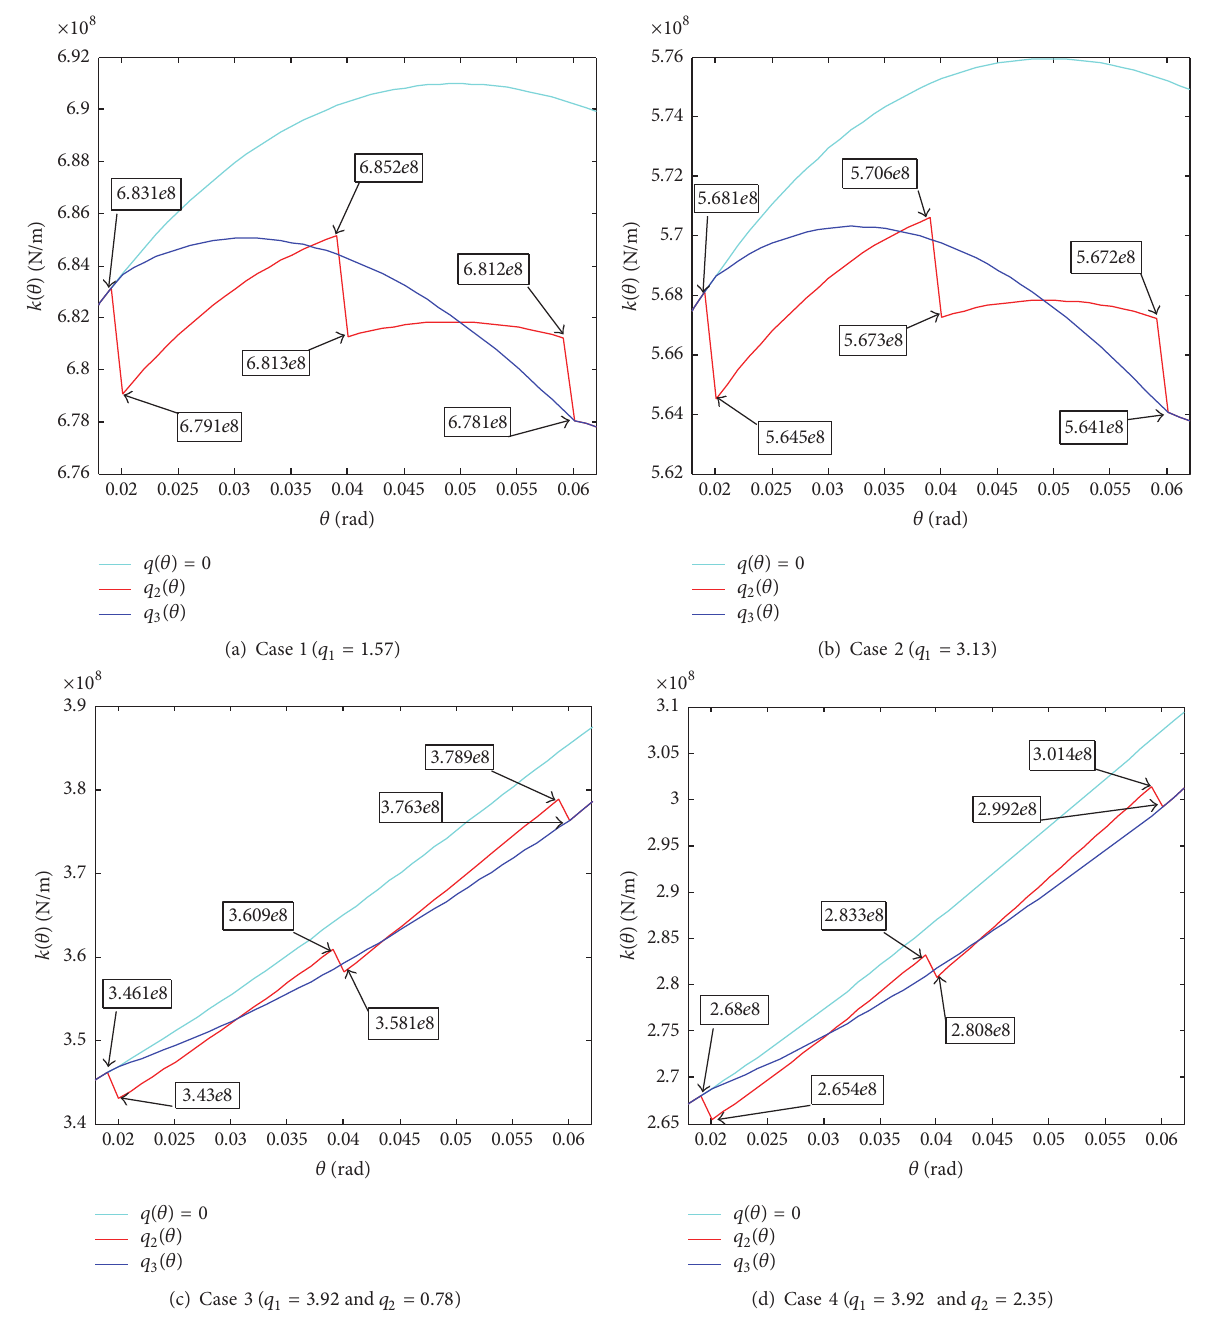
Figure 6: The influences of TPOC with the same length but different propagation models on mesh stiffness. 𝑞 2 (𝜃) and 𝑞 3 (𝜃) represent the crack propagating with the same length of 0.15 mm. 𝑞 2 (𝜃) represents the crack with the model of a continuous step function, indicating that the crack has instantaneously propagated by several continuous segments of length. 𝑞 3 (𝜃) represents the crack propagating with the model of a linear function, indicating that the crack has propagated continuously and smoothly. 𝑞(𝜃) = 0 represents the absence of